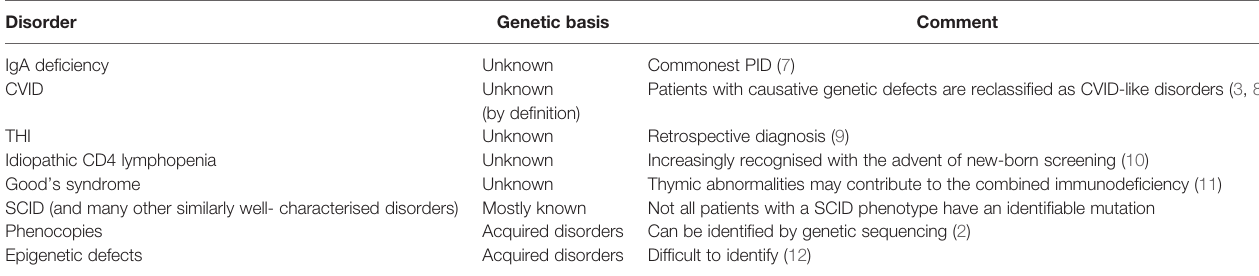
TABLE 1 | PIDs for which a causative genetic basis has not been identi fi ed in all patients. Disorder Genetic